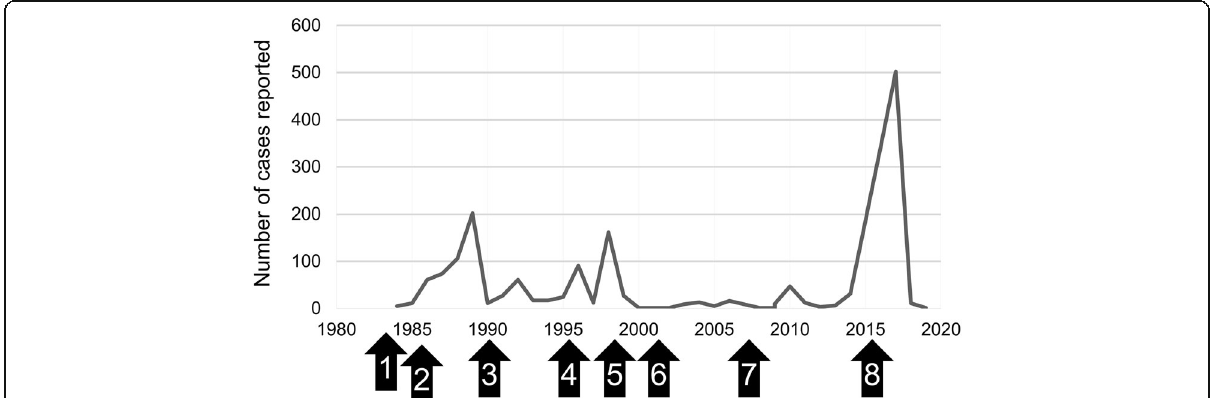
Fig. 4 Graphic showing the number of clinical reports of cinnarizine and flunarizine from 1980 to 2019. The numbers represent important markers of the history of the CNZ/FNZ-induced parkinsonism. (1) De Melo-Souza, a Brazilian neurologist, described the first to report FNZ-induced PKN. (2) Chouza and colleagues published the first report of FNZ-induced PKN. (3) Gimenez-Roldan and colleagues reported that essential tremor and older age were possible risk factors for CNZ-induced PKN. (4) Negrotti and Calzetti studied individuals with FNZ-induced PKN who had been followed for 7 years showing a bad prognosis. (5) Marti-Masso and Poza studied individuals with FNZ-induced PKN who had been followed for 10 years showing a relatively good prognosis. (6) Vazquez-Alen and colleagues showed a large decrease in drug-induced PKN; they hypothesized it was because of the reduction of CNZ/FNZ prescription. (7) Teive and colleagues called the FNZ and CNZ-induced PKN as De Melo e Souza ’ s syndrome. (8) Population-based studies using Taiwan and Korean